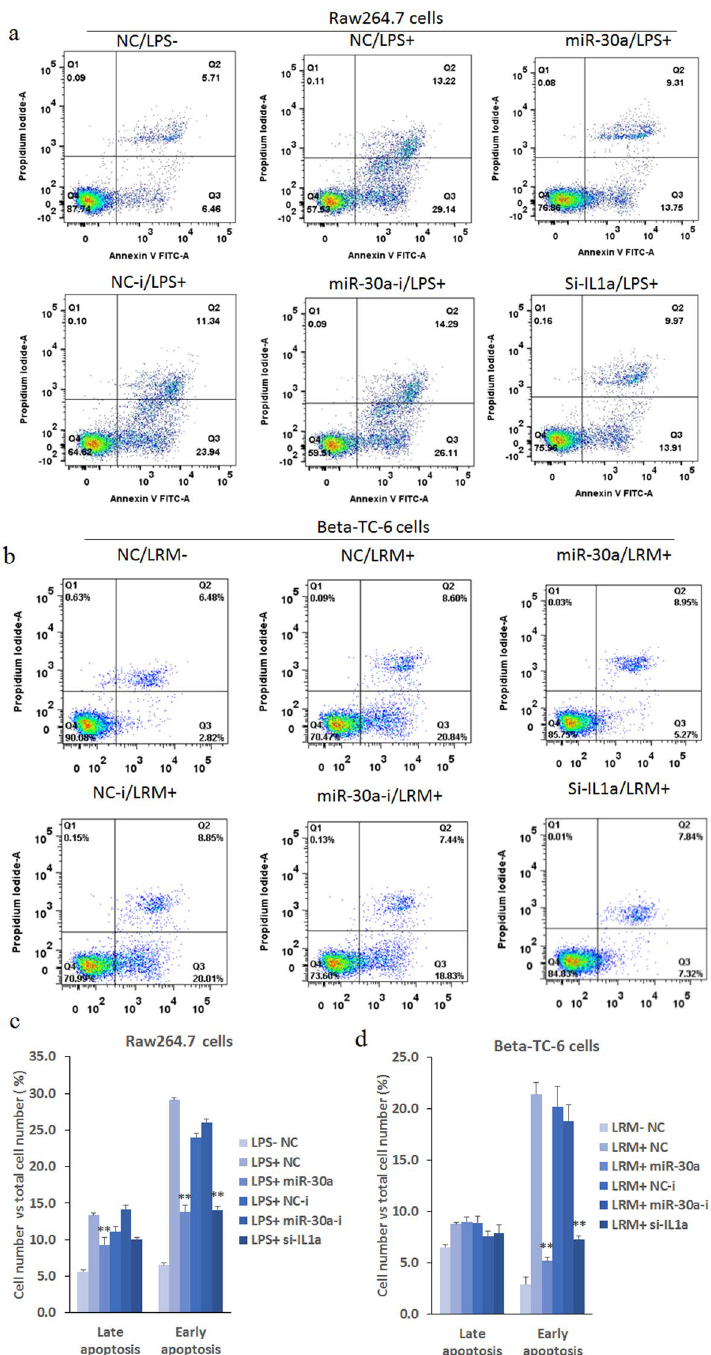
Figure 3. Effects of miR-30a mimics on apoptosis in RAW264.7 and Beta-TC-6 cells subjected to inflammatory stimulation measured by flow cytometry. ( a and c ) Flow cytometry showing that miR-30a mimics significantly inhibit the increased apoptosis in LPS-induced RAW264.7 cells. ( b and d ) Flow cytometry showing that miR-30a mimics significantly inhibited the increased apoptosis in LRM-induced Beta-TC-6 cells. LPS + / − , incubation with or without LPS; LRM + / − , incubation with or without LRM; NC, negative controls of miRNA mimics; NC-i, negative controls of miRNA inhibitors or siRNA; miR-30a-i, miRNA-30a inhibitor; and si-IL1a, silencing mRNA fragment of Il-1a. Data are expressed as the Mean ± SD (n = 3); ** P < 0.01 vs. NC or NC-i (LPS/LRM + ),